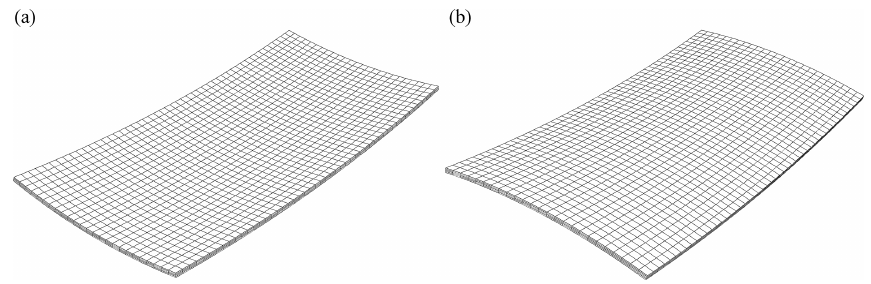
Figure 15. Deformation results for diverse loading paths based on the simplified deformation simulation method. (a) Result for Path 1 of pressed plate. (b) Result for Path 2 of pressed plate.